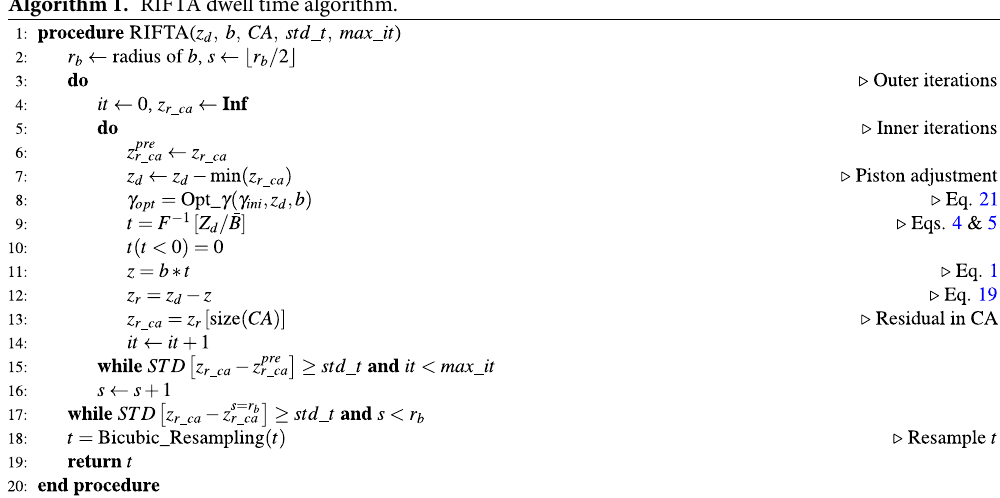
Algorithm 1. RIFTA dwell time